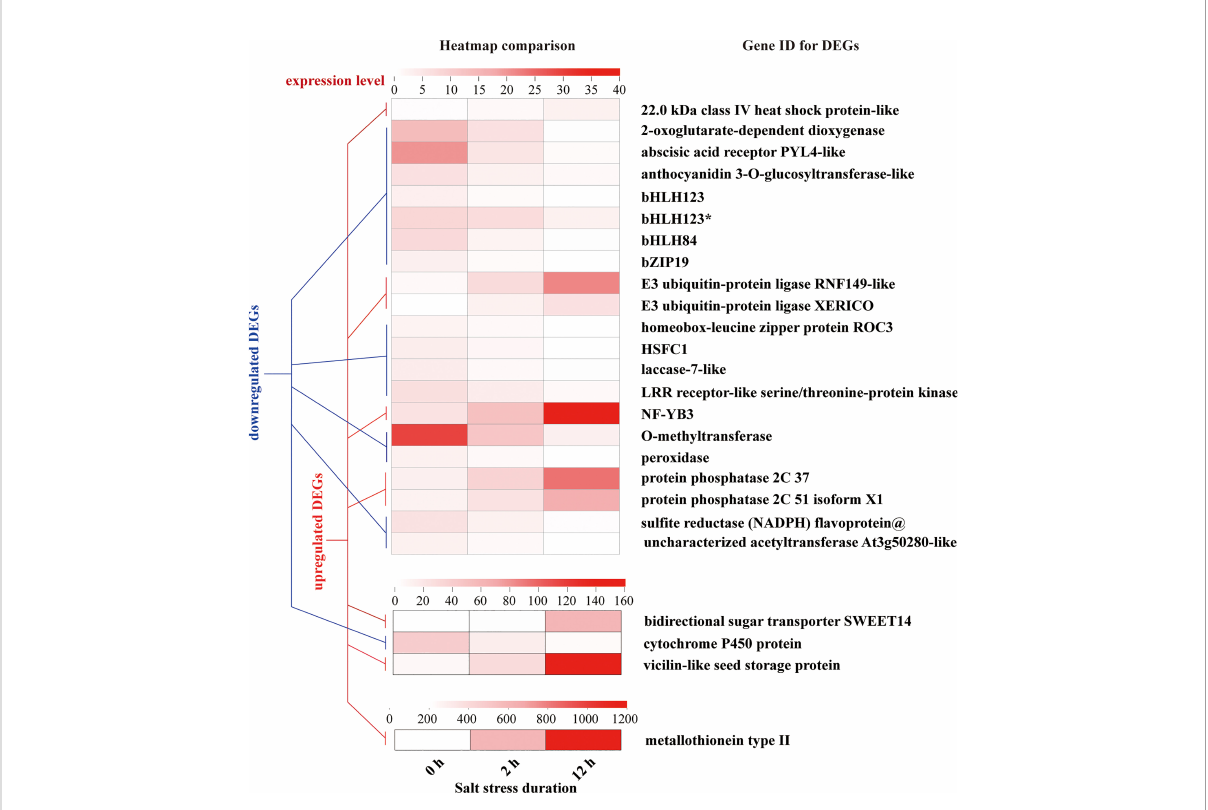
FIGURE 11 DEGs with the tendency of constant upregulation or downregulation during entire period (0-12 h) of salt stress. Each Gene ID of DEGs represents putative or predicted name based on one discovered in other eukaryotic organisms. “ * ” indicates the identical gene ID but different